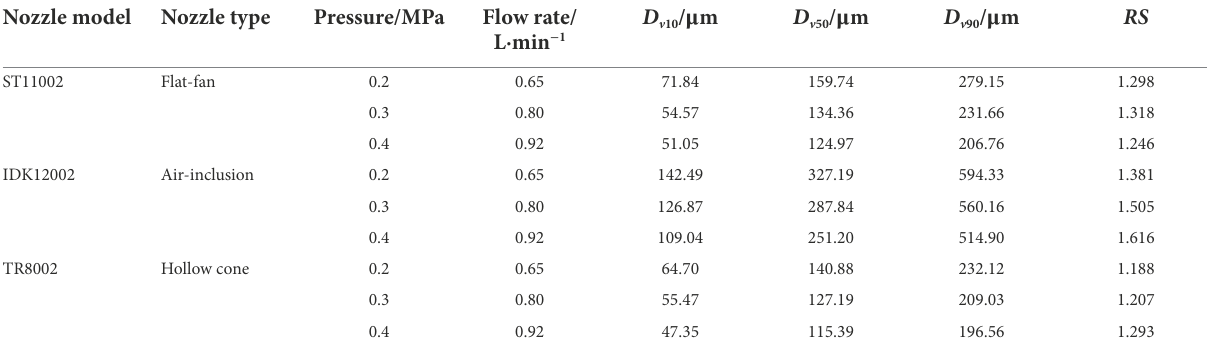
TABLE 2 Flow rate and droplet spectra of